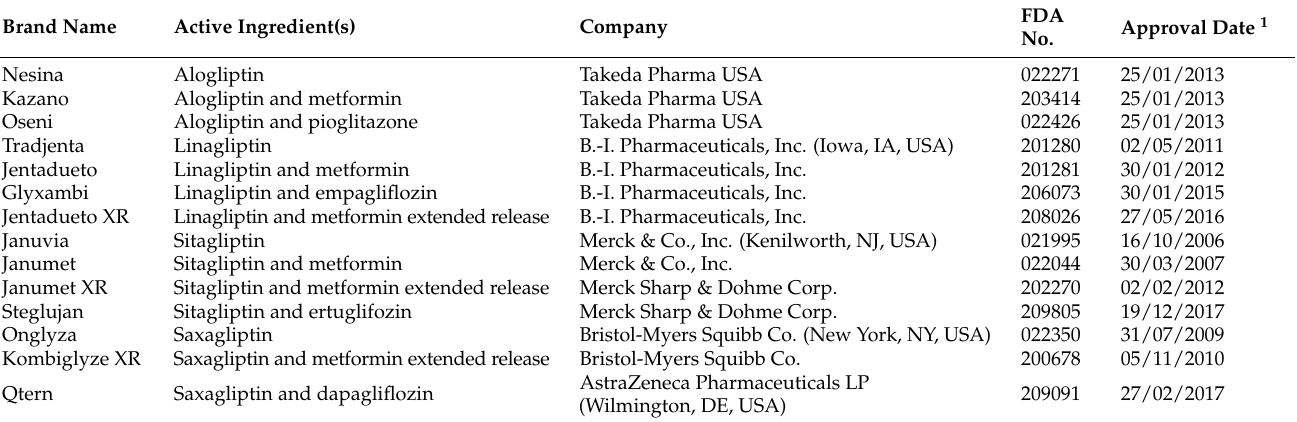
Table 2. List of USA Food and Drug Administration (FDA)-approved DPP4